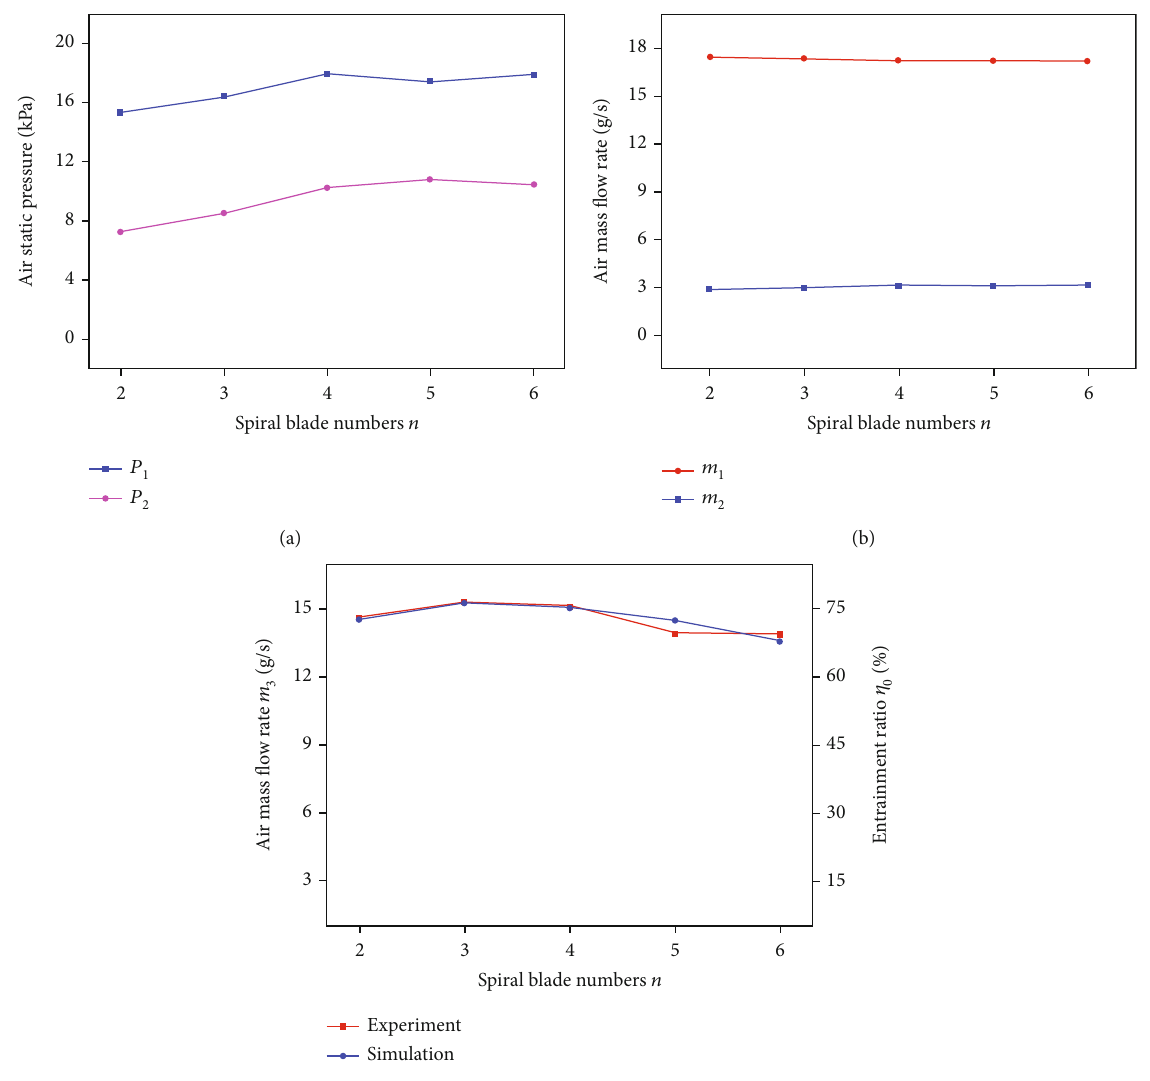
Figure 12: Relationship between number of spiral blades and entrainment performance of drill bit with fl ushing nozzles: (a) static pressure; (b) air mass fl ow rate m 1 and m 2 ; (c) entrainment